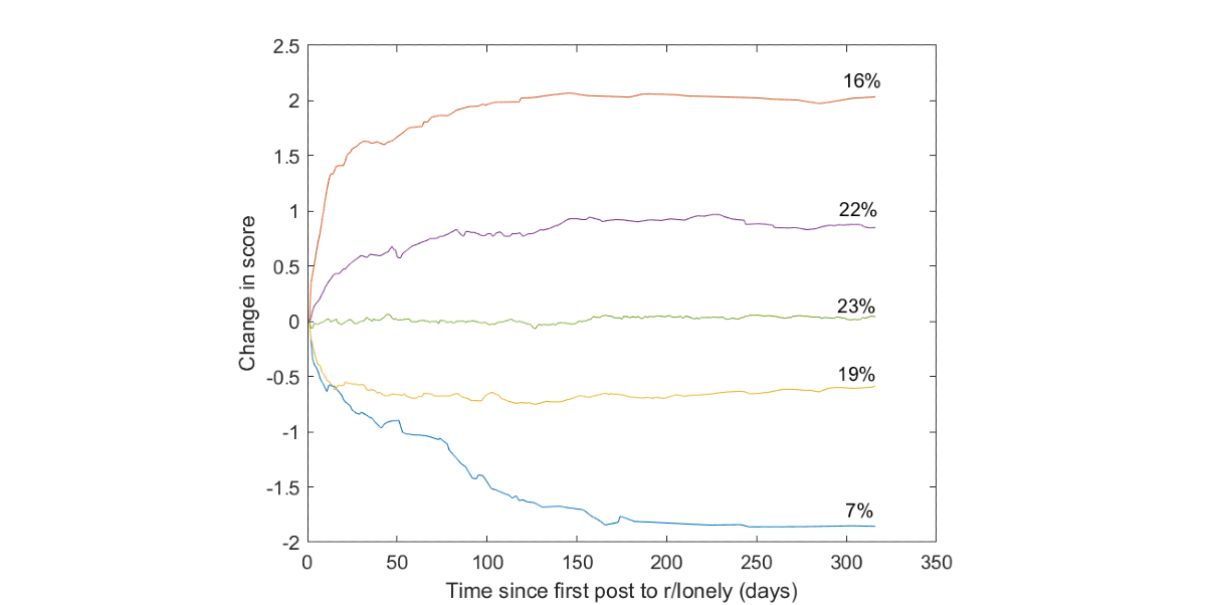
Figure 1. Centroids of users clustered over time by predicted loneliness scores and the percentages of users in each cluster who made posts in the suicide watch